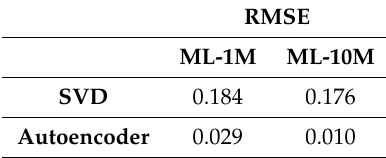
Table 4. RMSE comparison of autoencoder and Singular Value Decomposition (SVD) model